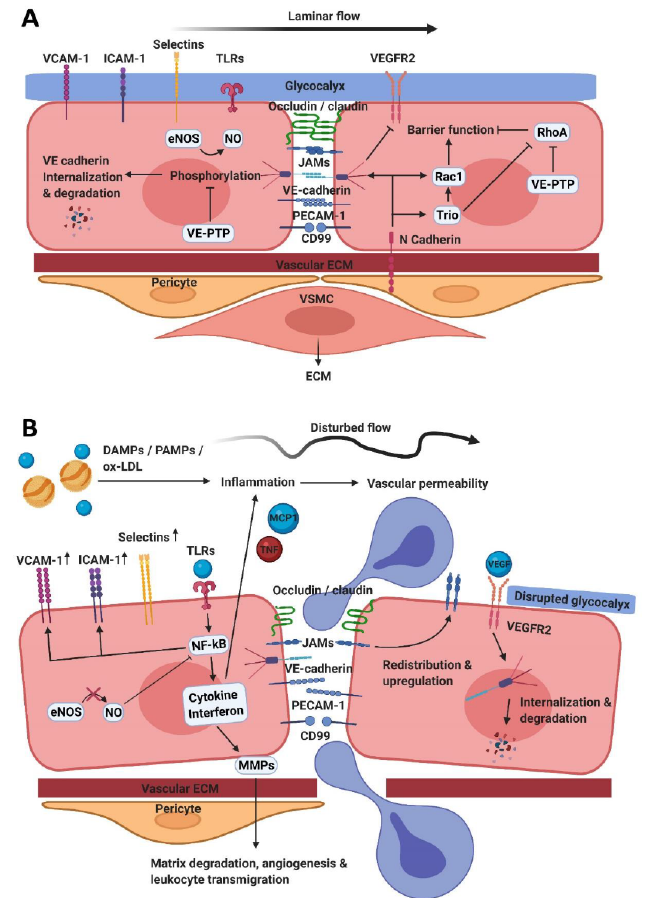
Figure 1. The endothelium under (patho)physiologic conditions. ( A ) Tight junctions, made by occludins, claudins, and JAMs, together with adherens junctions, formed by VE-cadherin, PECAM-1 and CD99 control endothelial barrier function by maintaining interendothelial junctions. Endothelial cells are connected to the vascular ECM, pericytes and VSMCs via N-cadherin and other interactions. N-cadherin activates Trio, Rac1 and also directly induces assembly of VE-cadherin junctions. Trio, as well as VE-PTP, inhibits RhoA. Additionally, VE-PTP prevents phosphorylation and subsequently degradation of VE-cadherin. NO is formed aiming to maintain a laminar flow together with the functional and intact glycocalyx. ( B ) Endothelial cells can become activated by disturbed flow and inflammatory mediators. VEGF activates VEGFR2 leading to internalization and degradation of VE-cadherin and TLR-activation results in NF- κ B-activation. This mediates upregulation of adhesion molecules and cytokine/interferon production. This ultimately leads to leukocyte transmigration, vascular permeability, matrix degradation and angiogenesis. AJs—adherens junctions; DAMPs— damage associated molecular patterns; ECs—endothelial cells; ECM—extracellular matrix; eNOS— endothelial nitric oxide; ICAM-1—intracellular adhesion molecule-1; JAMs—junctional adhesion molecules; MMPs—matrix metallo proteinases; NO—nitric oxide; ox-LDL—oxidized low-density lipoproteins; PAMPs—pathogen-associated molecular patterns; PECAM-1—platelet endothelial cell adhesion molecule-1; TJs—tight junctions; TLR—Toll-like receptor; VCAM-1—vascular adhesion molecule-1; VE-cadherin—vascular endothelial-cadherin; VEGF—vascular endothelial growth factor; VEGFR2—VEGF receptor 2; VE-PTP—vascular endothelial protein tyrosine phosphatase; VSMCs— vascular smooth muscle